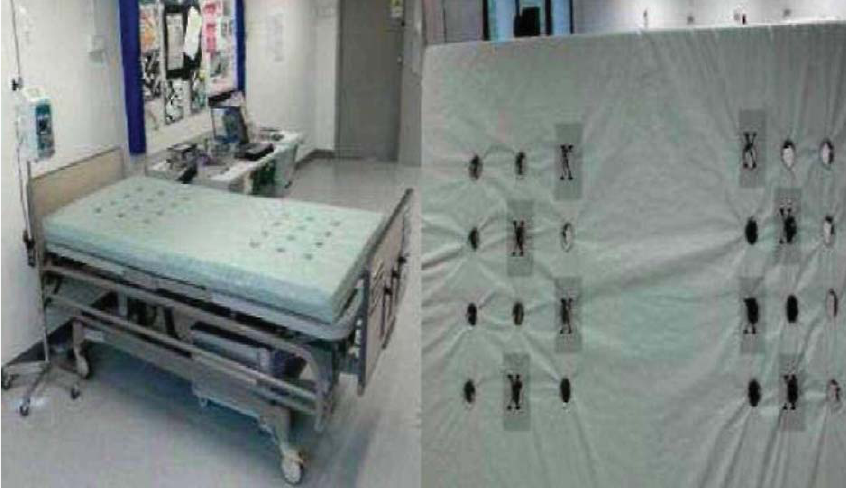
Fig. 3. Fabricated mattress with temperature sensors (Marked with X) implanted on potential